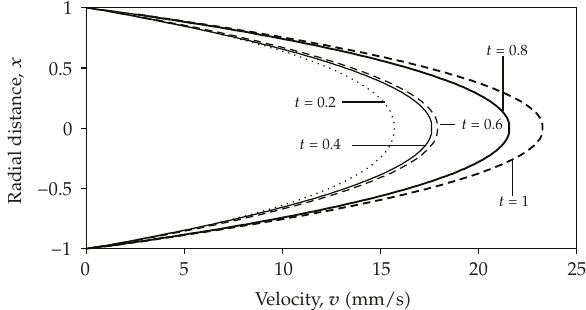
Figure 3: Velocity distribution at the middle of the stenosis for two fluid H-B models at di ff erent instants of time with α (cid:7) 0.95, φ (cid:7) 0.1 ◦ , τ m (cid:7) 0.1 a , μ H (cid:7) 0.035, and μ N (cid:7) 0.3 μ H .